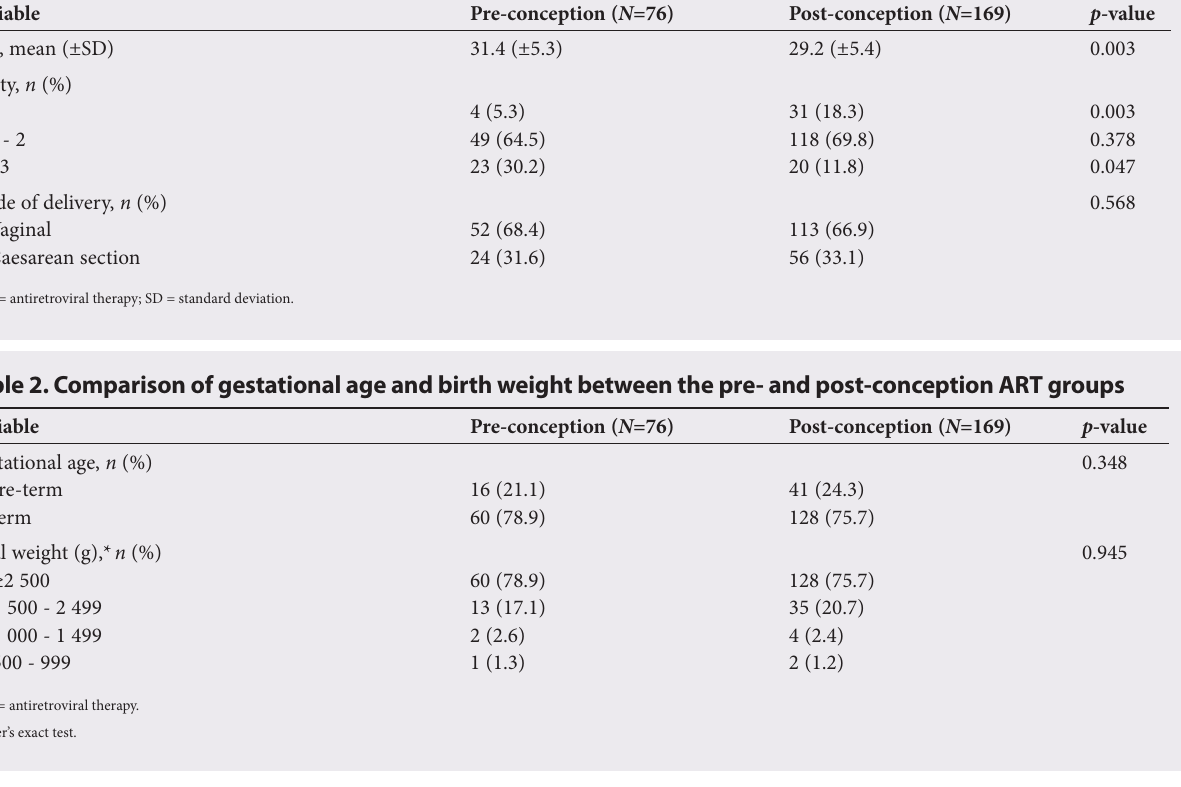
Table 1. Comparison of maternal age, parity and mode of delivery between the pre- and post-conception ART groups Variable